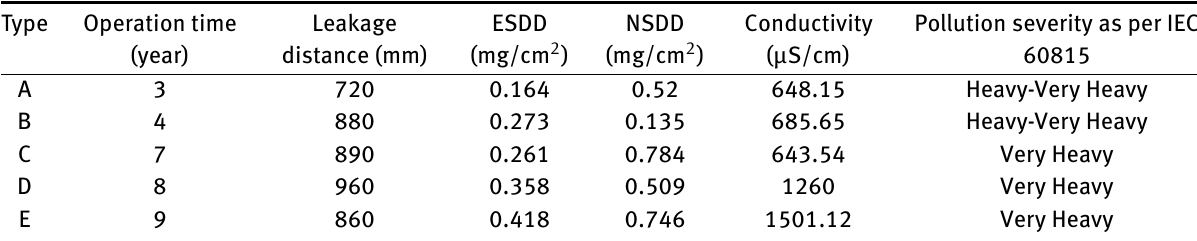
Table 1: ESDD, NSDD and conductivity measurements on five, 20 kV SiR insulators.